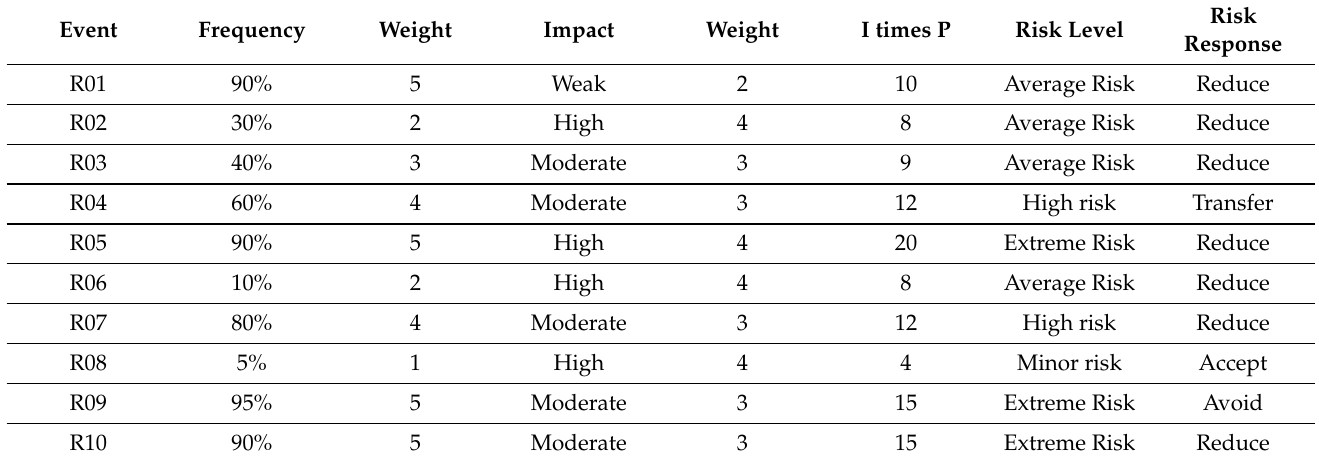
Table 10. Risk Assessment of the Promote Information and Communication Security